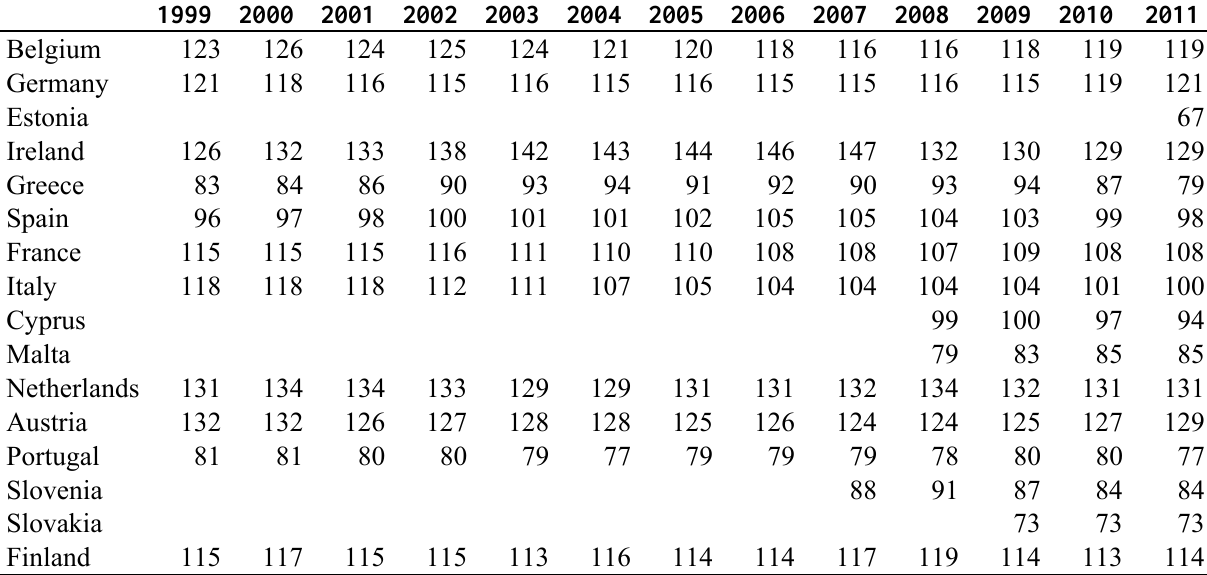
Table 2. GDP per capita in PPS of Eurozone countries, 1999–2011 *, EU27 =